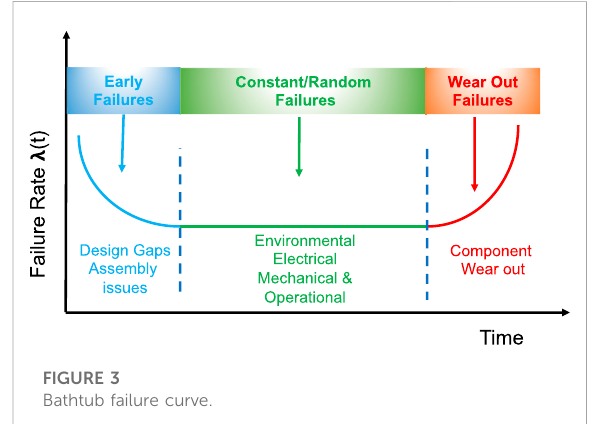
FIGURE 3 Bathtub failure